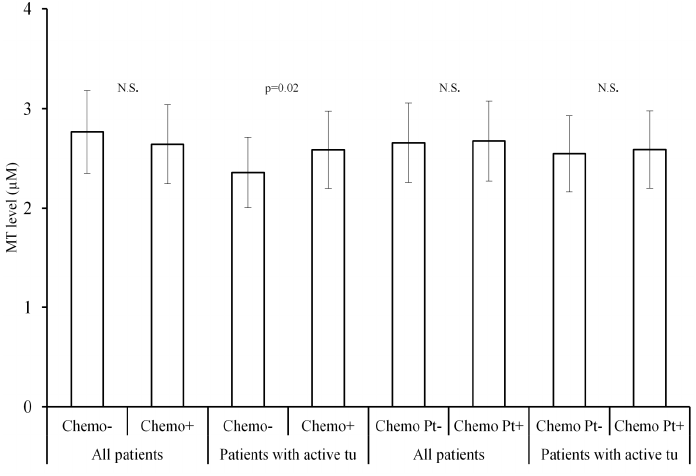
Figure 4. MT levels in relation to chemotherapy. N.S.: not significant. p = 0.02: statistically